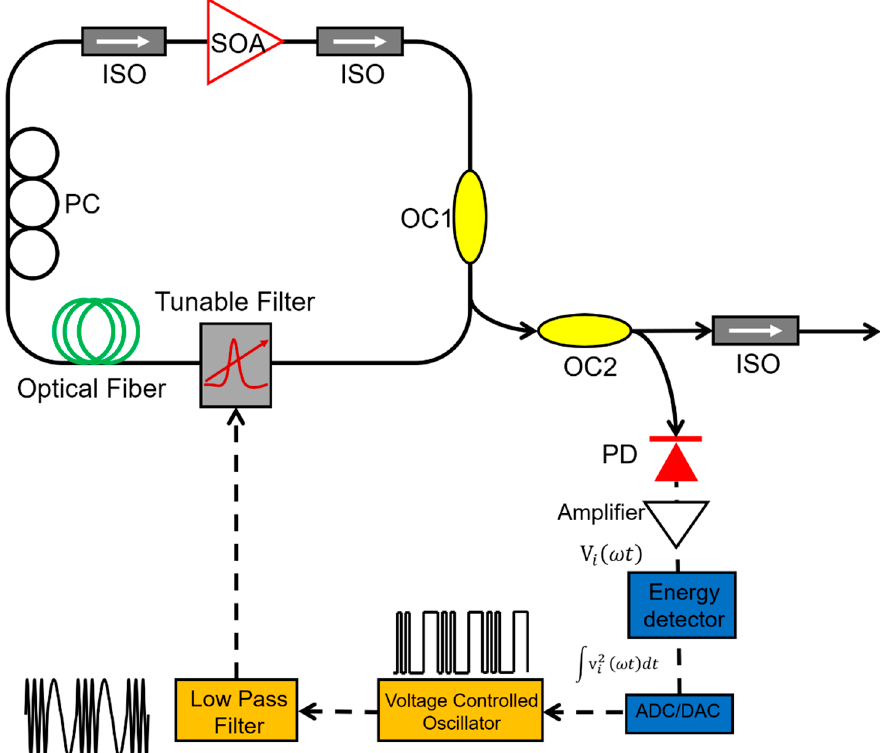
Figure 11. Schematic diagrams of the self-starting, self-regulating FDML laser. Adapted with permission from Ref. [109].